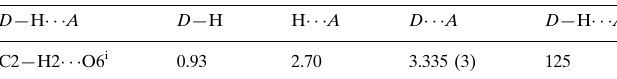
Hydrogen-bond geometry (A˚ , (cid:1)